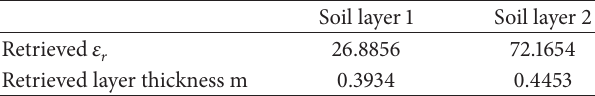
Table 2: Retrieved permittivities and thicknesses.